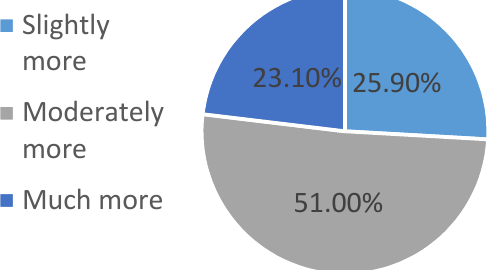
Figure 2. Changes in the percentage of meals prepared in the household before and during the COVID-19 pandemic.